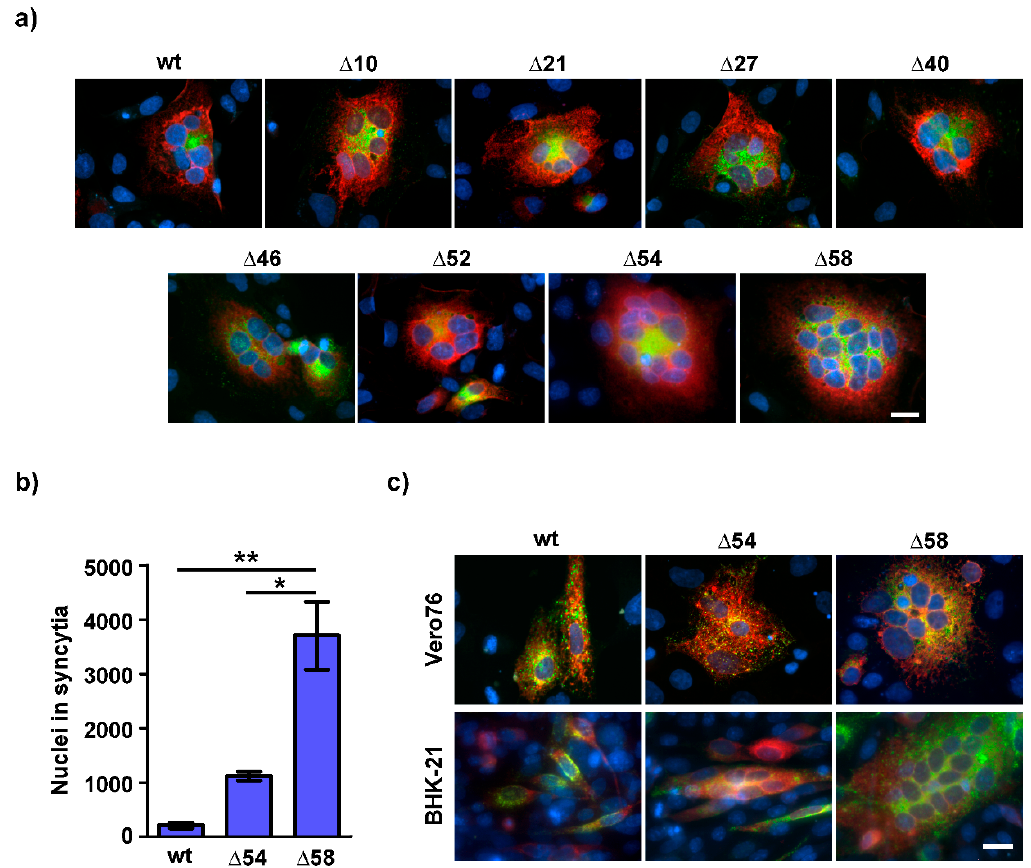
Figure 2. Truncation of the CD of GhV G results in an increased fusogenicity in bat and non-bat cells. ( a ) Coexpression of GhV F and wildtype or truncated G proteins in EidNi / 41 cells. At 24 h p.t., cells were fixed, permeabilized, and incubated with antibodies for the detection of F and G proteins. Green: F, red: G, blue: nuclei. Scale bar indicates 20 µ m. ( b ) The total number of nuclei in syncytia per coverslip was counted in GhV F and G (wildtype, ∆ 54 or ∆ 58) cotransfected EidNi / 41 cells. The graph shows mean and SEM of three independent trials. Statistical significance was tested by paired, two-tailed Student’s t-test with 95% confidence intervals (*: p ≤ 0.05; **: p ≤ 0.01). A syncytium was defined as a multinucleated cell with positive staining for GhV F and G, containing at least three nuclei. ( c ) Coexpression of GhV F and wildtype or truncated G proteins in Vero76 and BHK-21 cells. Green: F, red: G, blue: nuclei. Scale bar indicates 20 µ m.